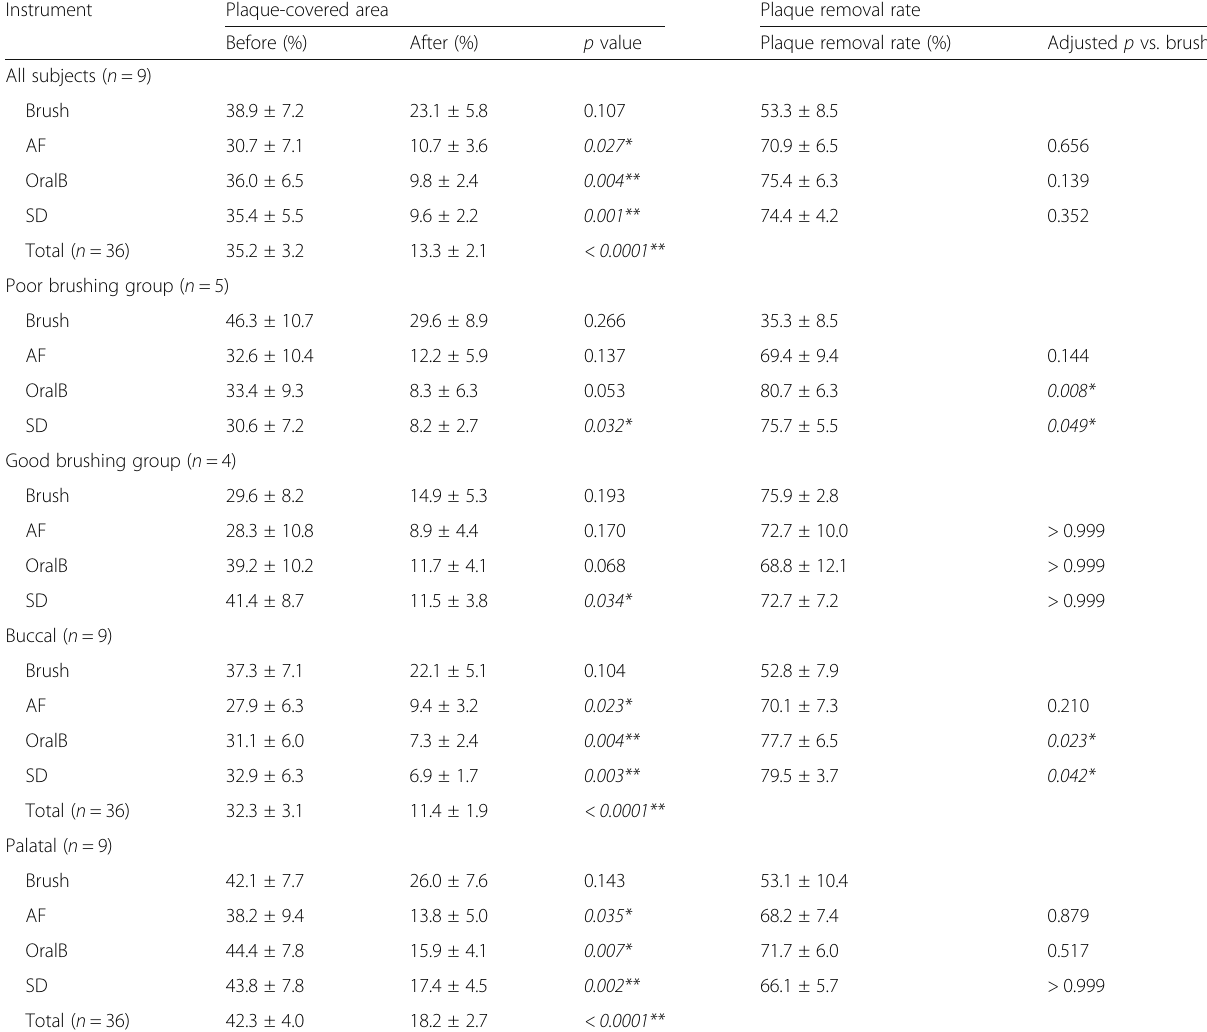
Table 1 Plaque-covered areas before and after brushing and plaque removal rates Instrument Plaque-covered area Plaque removal rate